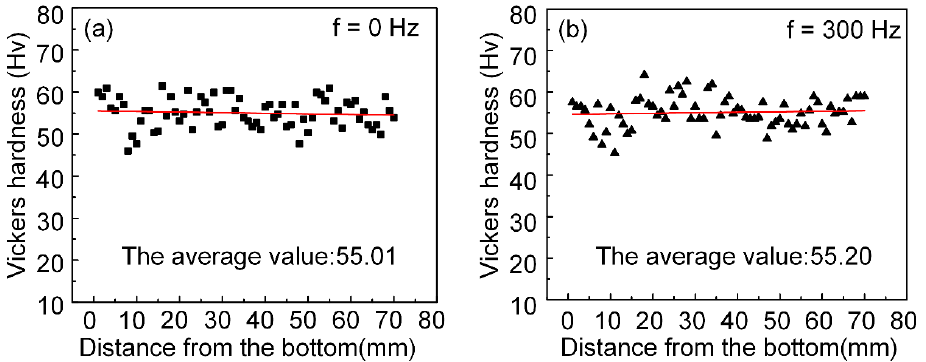
Figure 10. Distribution of hardness values along the height direction for the component. ( a ) 0 Hz; ( b ) 300 Hz.